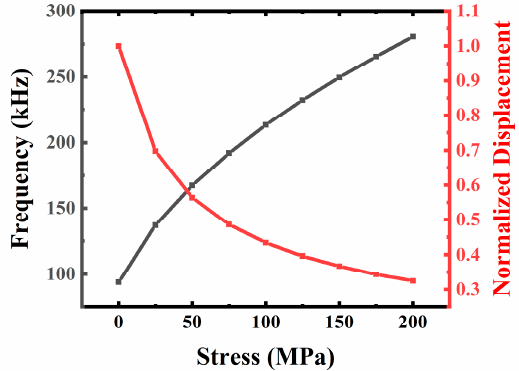
Figure 9. FEM simulation results of the normalized dynamic mechanical amplitude and resonant frequency for bimorph PMUT with different tensile residual stress.